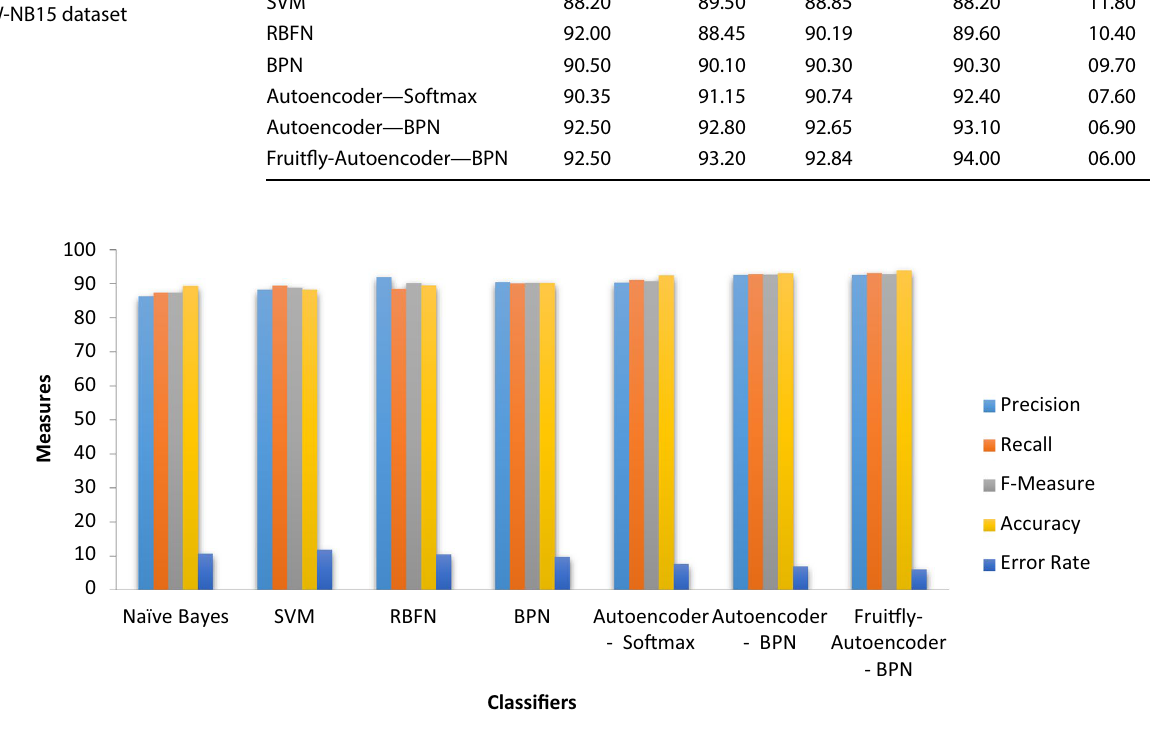
Table 14 Comparative analysis of proposed intrusion detection system with existing benchmark classifiers on UNSW-NB15 dataset